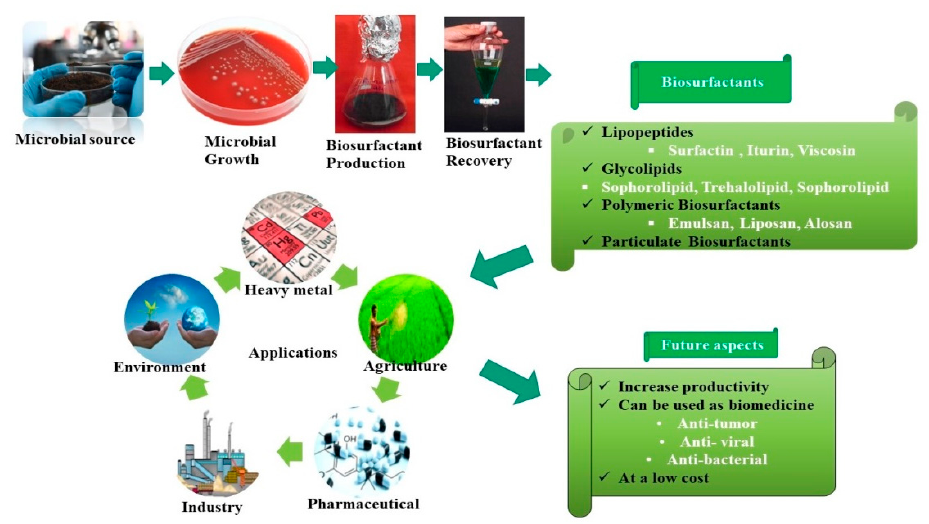
Figure 2. Schematic representation of biosurfactant production utilizing microbial resources and their potential applications.